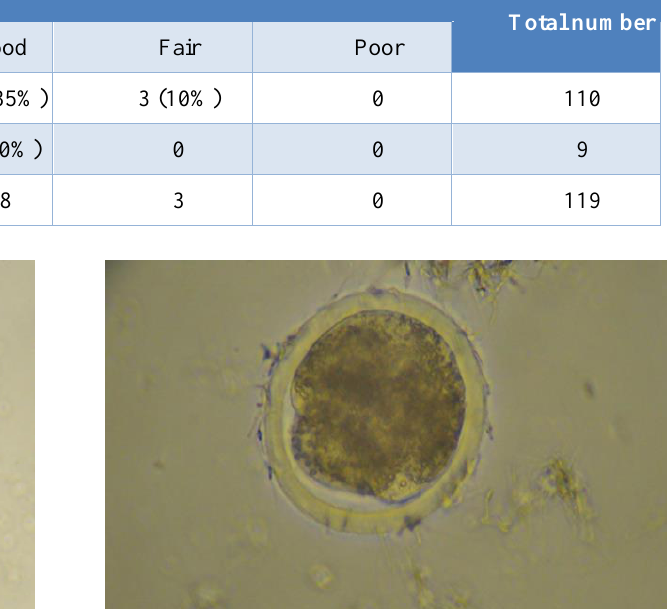
Figure, 7: two cells embryo 24-36 hrs. after IVF.